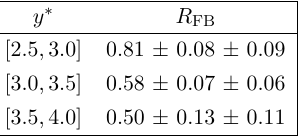
Table 6 . R FB ratio as a function of j y (cid:3) j in the range 2 < p T < 10 GeV =c . The (cid:12)rst uncertainty is statistical and the second is